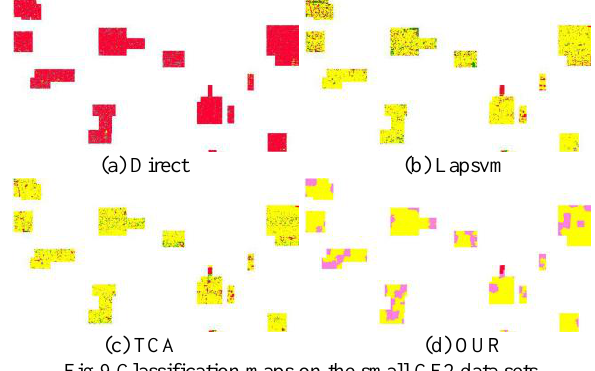
Fig.9 Classification maps on the small GF2 data sets.